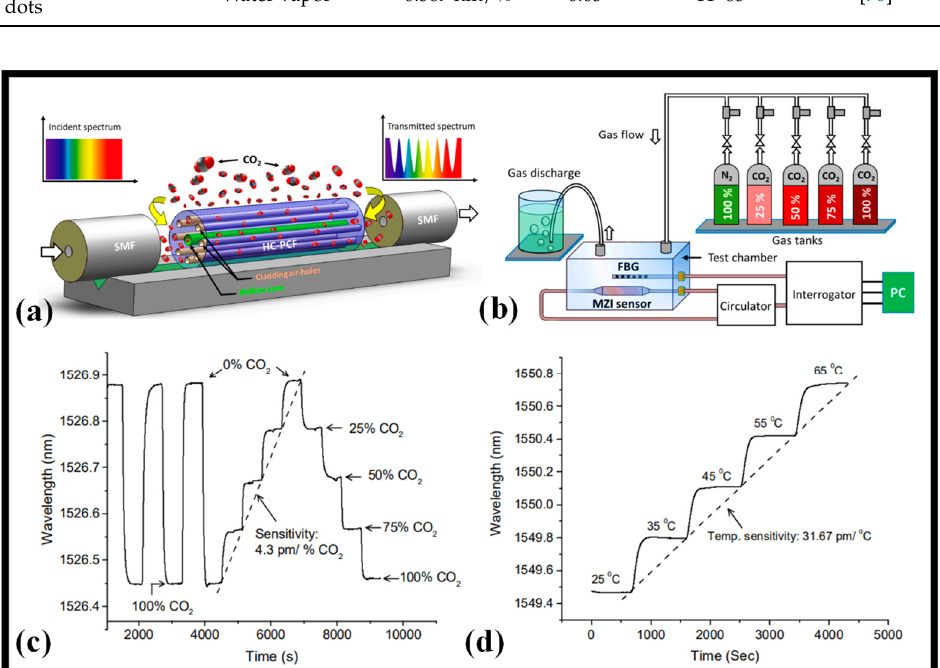
Figure 3. HC-PCF-based gas sensor, ( a ) schematic of MZI developed using a small stub of HC-PCF [58], ( b ) experimental schematic for sensor characterization and interrogation [58], ( c ) the response of the sensor to CO 2 gas concentration [58], ( d ) the response of the sensor to temperature change [58]. Table 1. Optical fiber-based gas sensors.